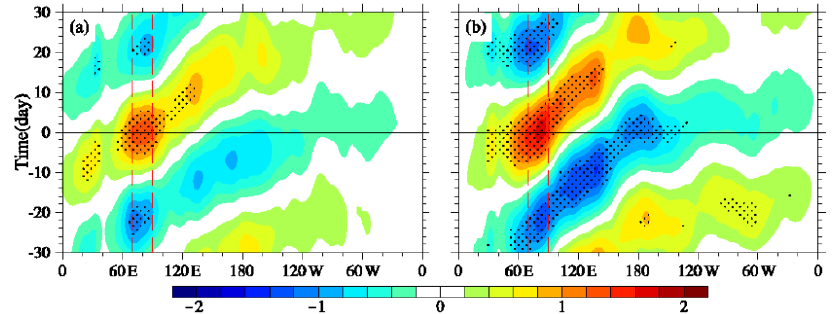
Figure 7. Longitude-time diagram of the MJO zonal winds at 850 hPa averaged over the 10° S–10° N lag regressed onto that averaged over the 10° S–10° N, 70°–90° E during the ( a ) positive and ( b ) negative phases of PIOAM. Results passing the significance test at the 90% confidence level are stippled.